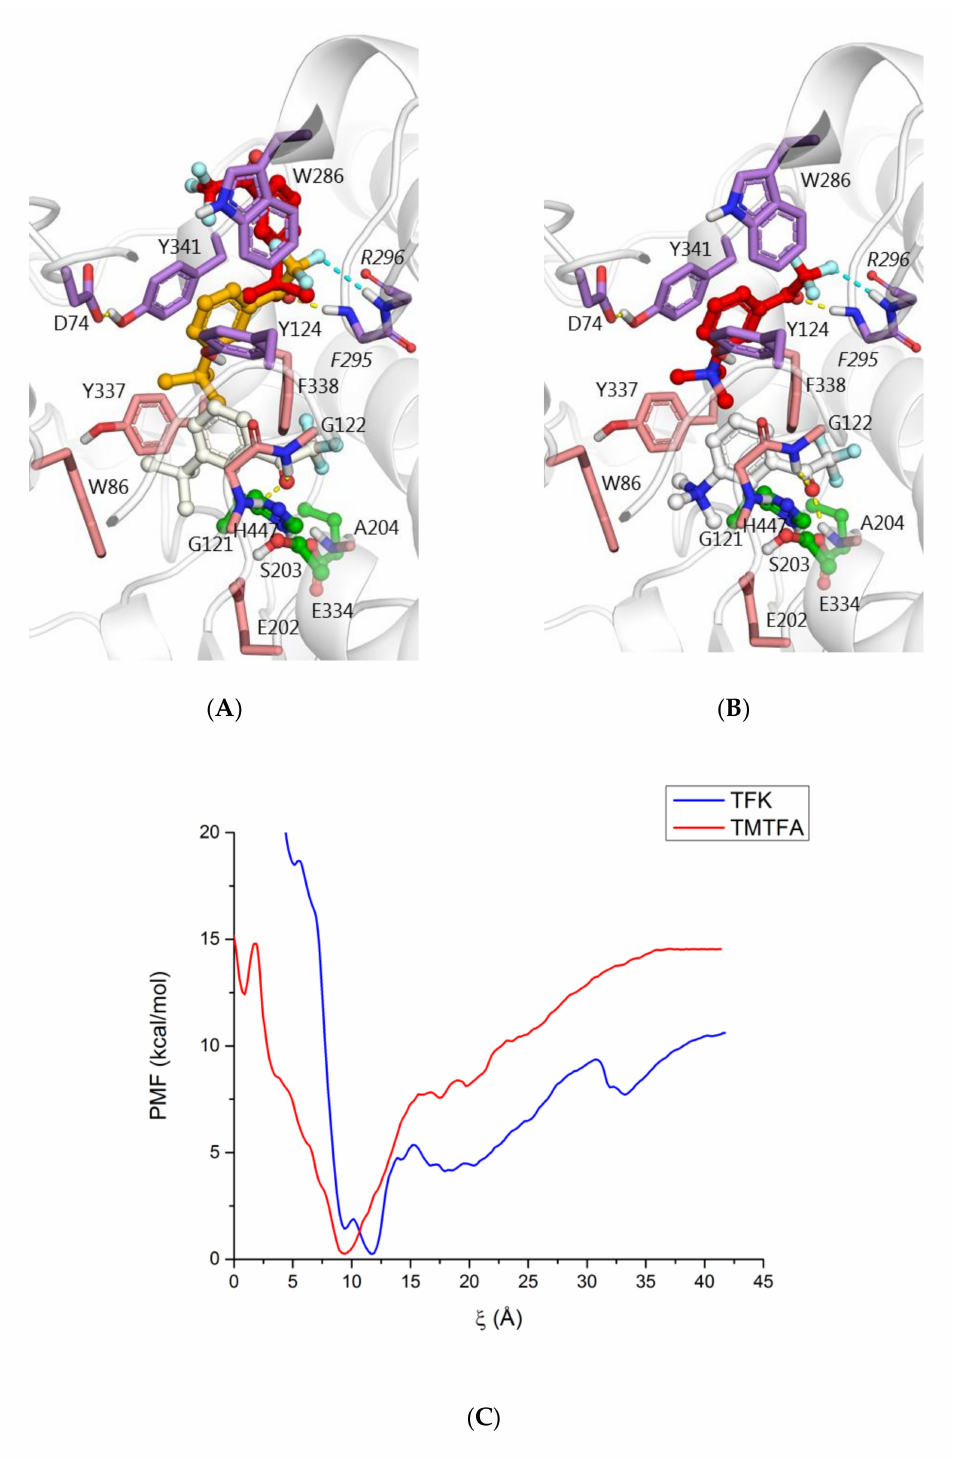
Figure 7. Binding of TFK to AChE: ( A ) main docked poses in the gorge: in the PAS (most populated cluster, carbon atoms colored red), at the gorge rim partly blocking the bottleneck (carbon atoms orange), and in the active site ready to react with the catalytic serine (least populated cluster, carbon atoms are colored white) compared to the main binding poses of TMTFA ( B ). Docking results with X-ray structure PDB ID: 4EY7 as a target are shown. ( C ) Free energy (PMF) profile of the binding process calculated with REMD-US method. Process coordinate ξ is the distance between the TFK / TMTFA trifluoroketone group and the active site, oxyanion hole and catalytic serine